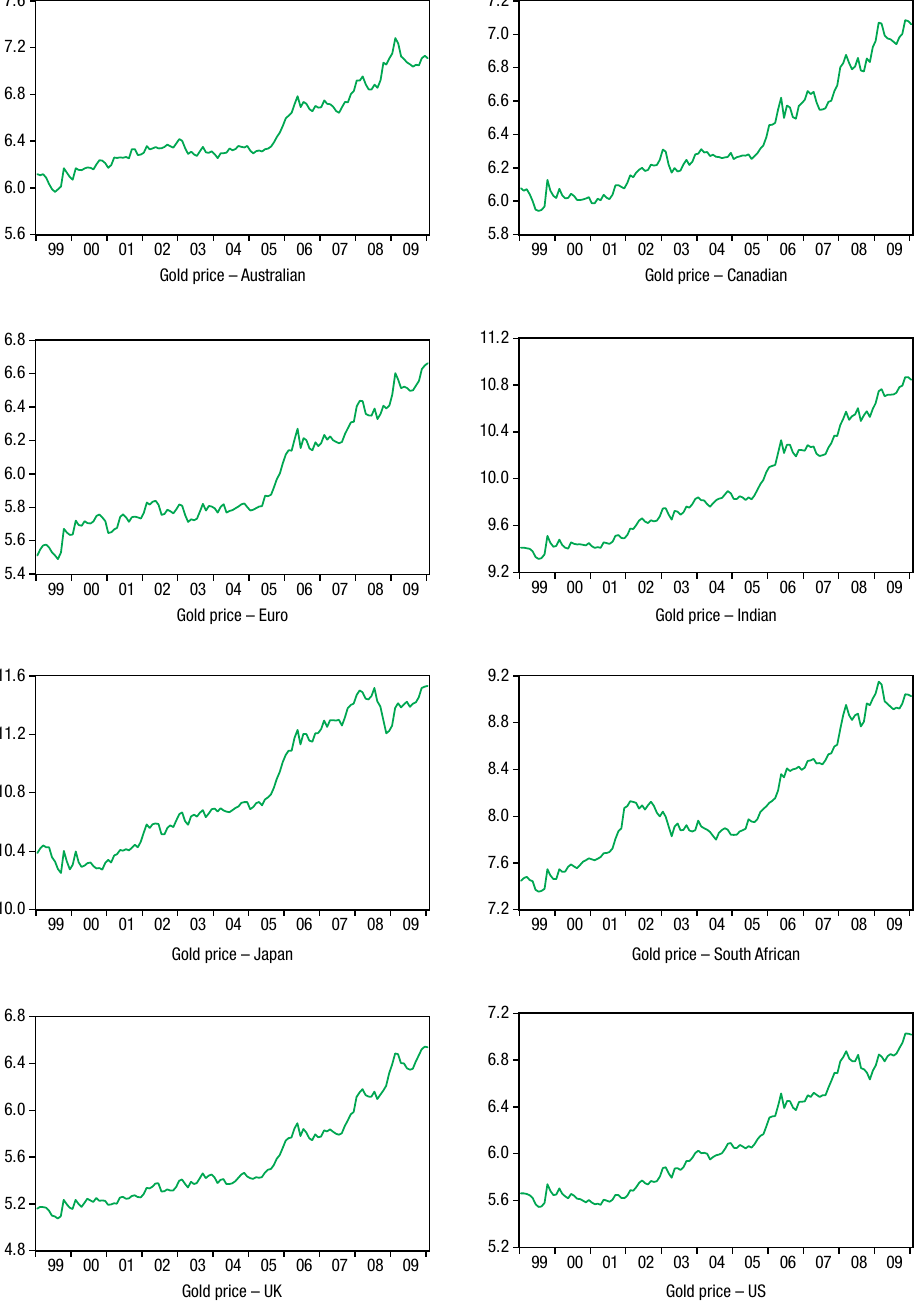
Fig. 3. The trends of the gold